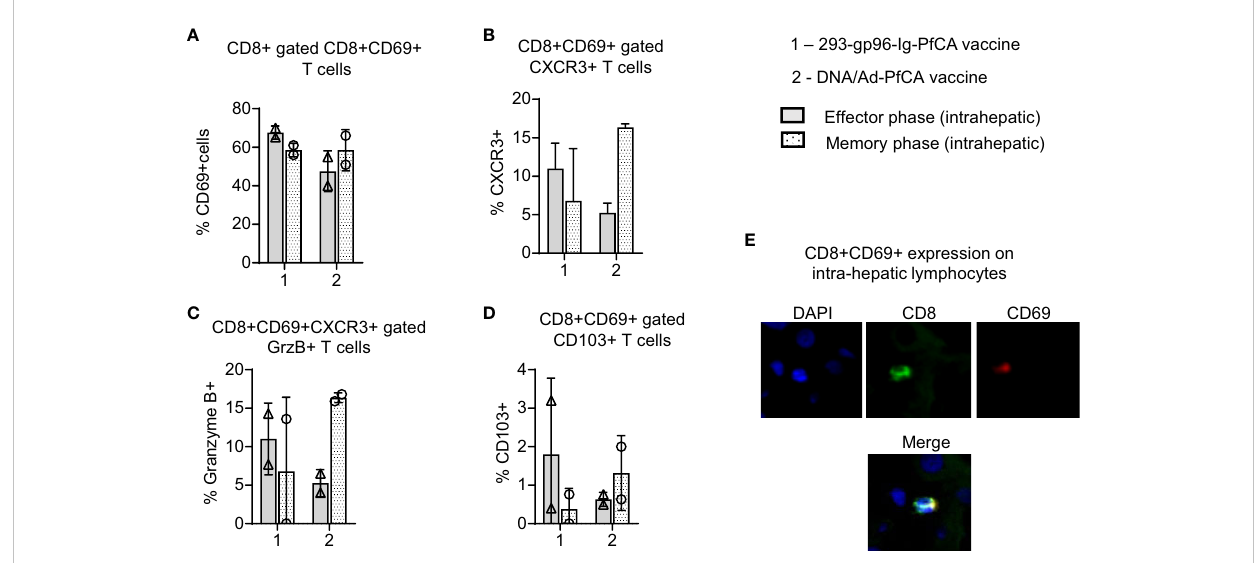
FIGURE 4 293-gp96-Ig-PfCA vaccinated rhesus macaques induce intrahepatic memory CD8+ T cells expressing Trm phenotype. Characterization of intrahepatic memory CD8+ T cell responses in rhesus macaques at effector (1 week, n=2) and memory (11 weeks, n=2) time-points following the third dose of the 293-gp96-Ig-PfCA vaccine. Control animals received DNA/Ad5-PfCA vaccine and were sacri fi ced at effector (3 weeks, n=2) and memory (11 weeks, n=2) time-points following the Ad5 boost. Optimal effector time-points of the two vaccines were determined based on the prior study results. Intrahepatic lymphocytes stained with the surface markers: CD3, CD8, CD69, CXCR3, CD103 and intracellular granzyme B (GrzB) were analyzed by fl ow cytometry to determine the frequency of (A) CD8+ gated CD8+CD69+ T cells (B) CD8+CD69+ gated CXCR3+ T cells (C) CD8 +CD69+CXCR3+ gated GrzB+ T cells (D) CD8+ gated CD69+CD103+ T cells. (E) Frozen liver tissue sections (at week 26) of 293-gp96-Ig-PfCA vaccinated macaques showing expression of CD8 (green) and CD69 (red) with co-localization (yellow). Original magni fi cation 40X with DAPI nuclear staining shown in blue. Data represent individual values and mean ± standard